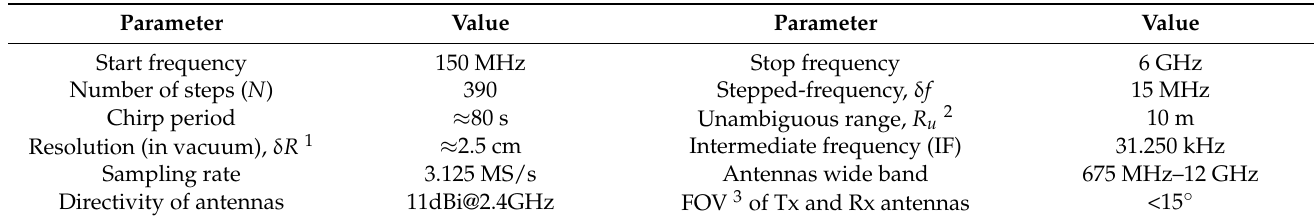
Table 1. SFCW radar